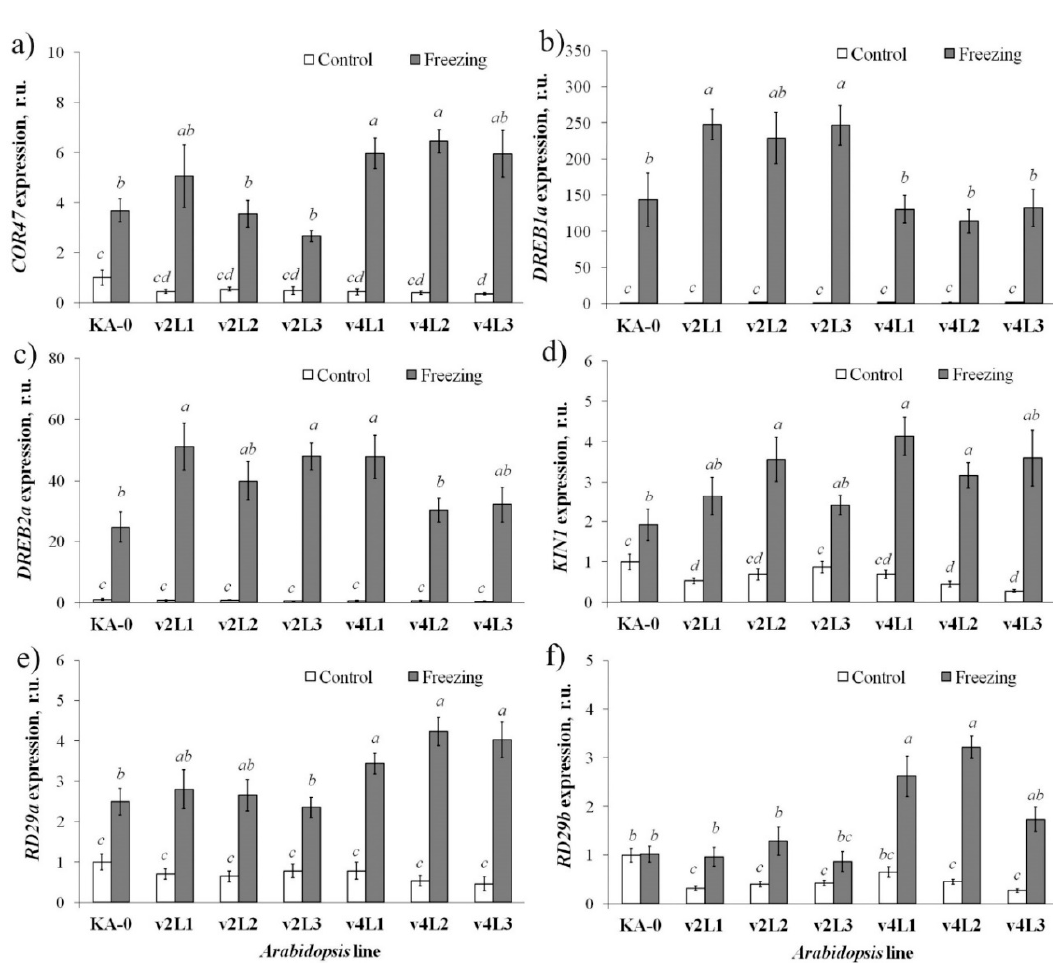
Figure 7. The expression of stress-responsive genes AtCOR47 ( a ), AtDREB1A ( b ), AtDREB2A ( c ), AtKIN1 ( d ), AtRD29A ( e ), and AtRD29B ( f ) in transgenic Arabidopsis transformed with the VaCML21v2 and VaCML21v4 s plice variants in response to freezing stress. The 4-week-old control KA-0, 35S:: VaCML21v2 (lines v2L1, v2L2, and v2L3), and 35S:: VaCML21v4 (lines v4L1, v4L2, and v4L3) plants were exposed to control conditions (at 22 o C) or freezing (at -10 o C for 45 min and then cultured at +4 °C for 1 h for recovery). Total RNA was extracted from plants just before freezing (white bars) and 1 h after freezing (grey bars). The data are presented as the mean ± SE (two independent experiments). Means followed by the same letter were not different using one-way analysis of variance (ANOVA), followed by the Tukey HSD multiple comparison test. A value of p ≤ 0.05 was considered significant.